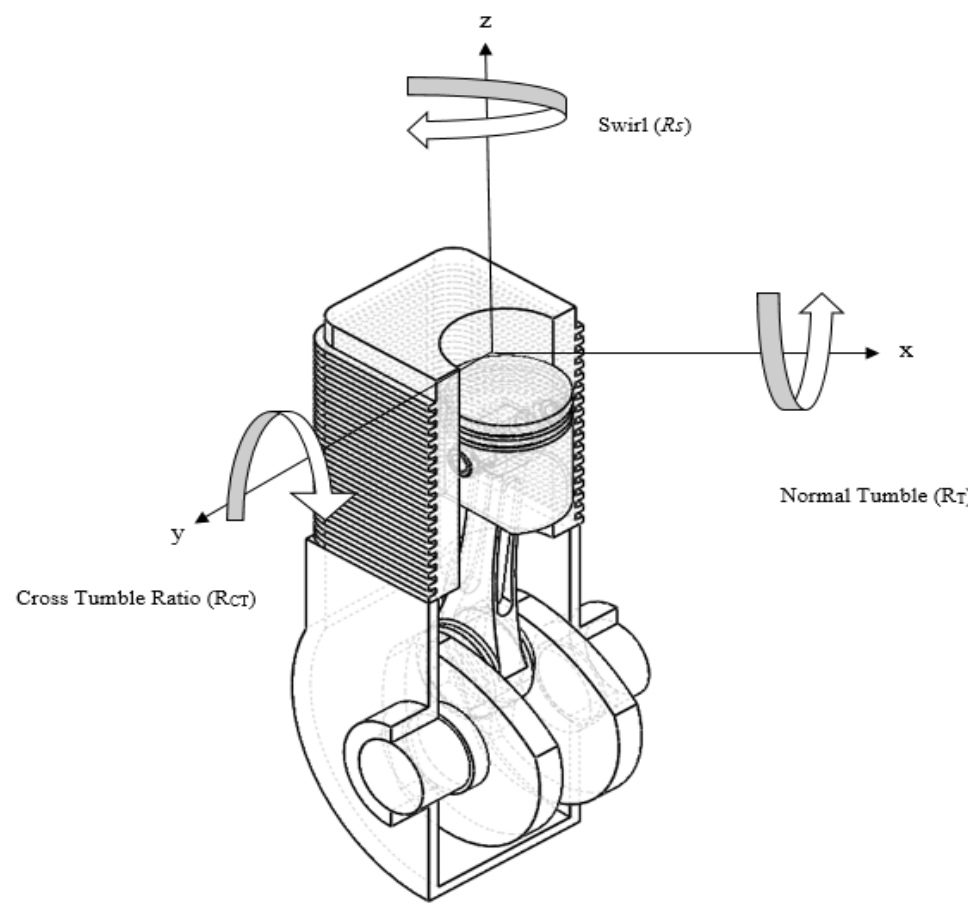
Figure 6. Swirl, tumble, and cross tumble ratio orientations.